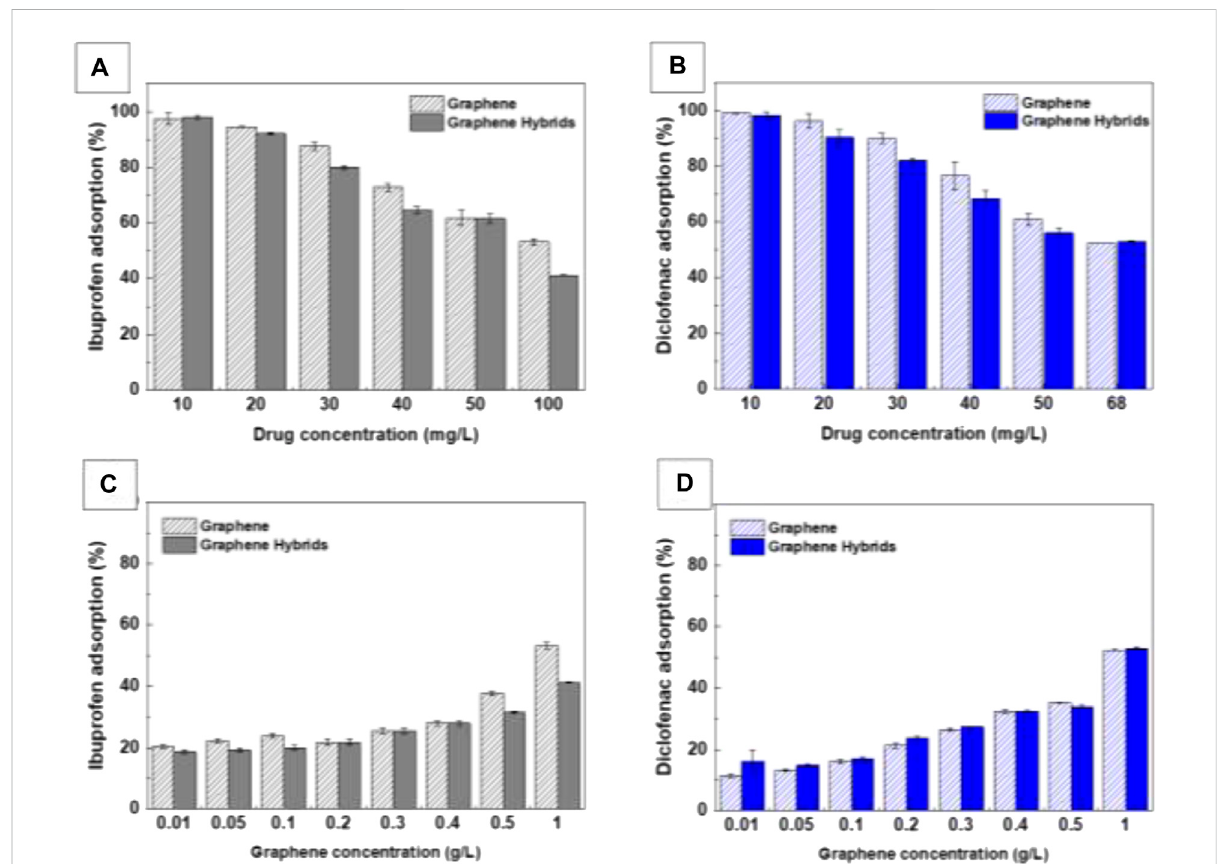
FIGURE 5 AdsorptionisothermsofGraphene andGraphene hybrids.AdsorptionofIBP (A) andDCFsolutions (B) atdifferentdrug concentrations exposed to Graphene/Fe 3 O 4 hybrids (3.2 · 10 15 NPs/g graphene; 1 g/L graphene). Adsorption of IBP (C) and DCF (D) (EC 50 concentrations) exposed to varying concentrations of Graphene/Fe 3 O 4 hybrids (3.2 · 10 15 NPs/g Graphene) and